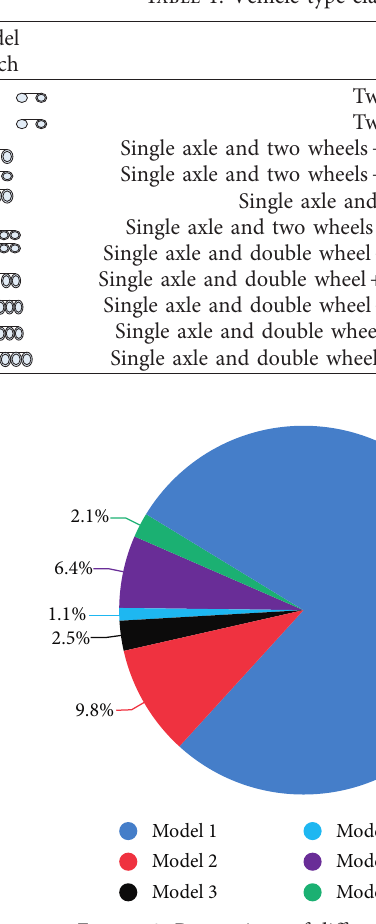
Figure 3: Proportions of different vehicle